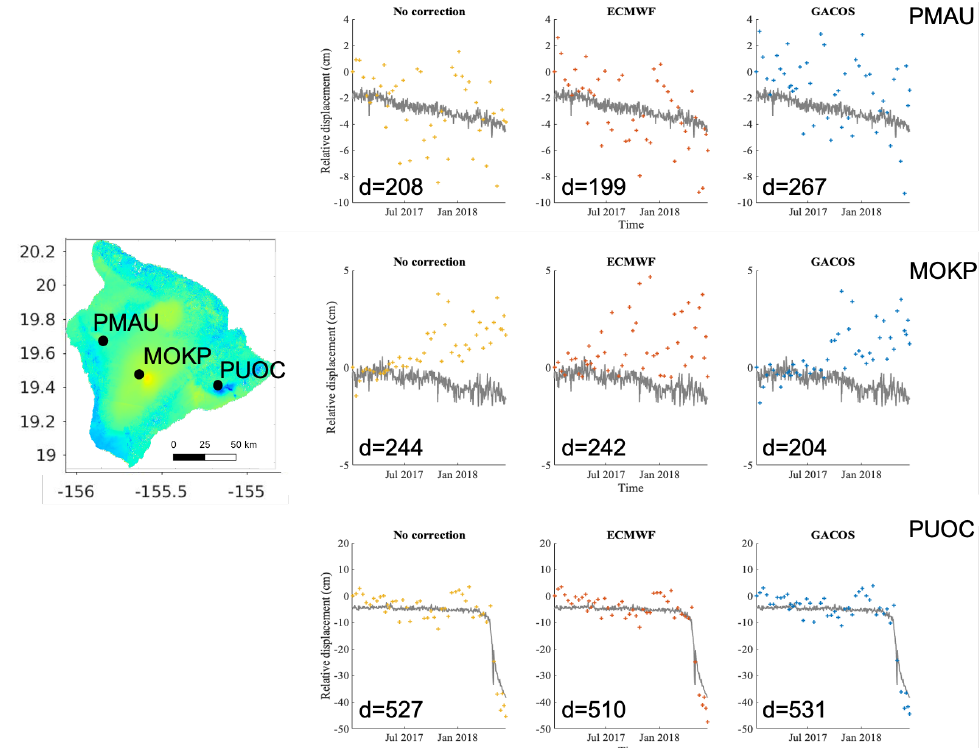
Figure 5. Left: Location of the three GNSS stations that we used for the comparison. Right panels: Comparison of GNSS time series and the displacement time series of the corresponding DInSAR pixel. Grey lines show the GNSS displacement converted to the satellite Line-of-Sight (LOS), and yellow, orange and blue symbols show the DInSAR time series for the different atmospheric corrections applied: no correction applied, the ECMWF correction applied and the GACOS correction applied, respectively. The Euclidean distance, d , is shown in each panel, where the smaller value represents a better fit between the time